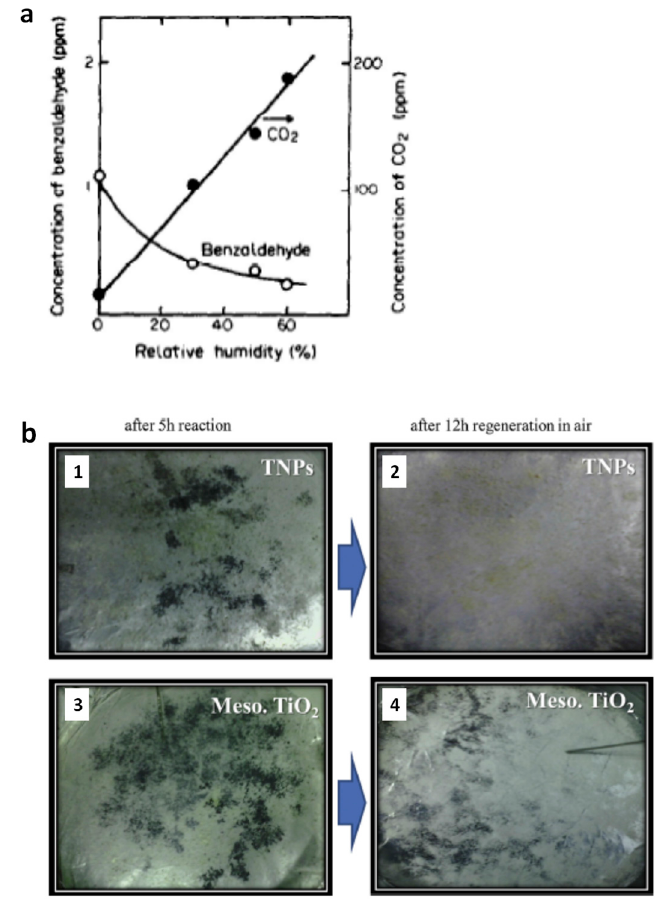
Figure 9. ( a ) Effect of relative humidity Reprinted with permission from Ref. [90] 2022, Elsevier and ( b ) effect of heat treatment Reprinted with permission from Ref. [92] 2022, Elsevier.